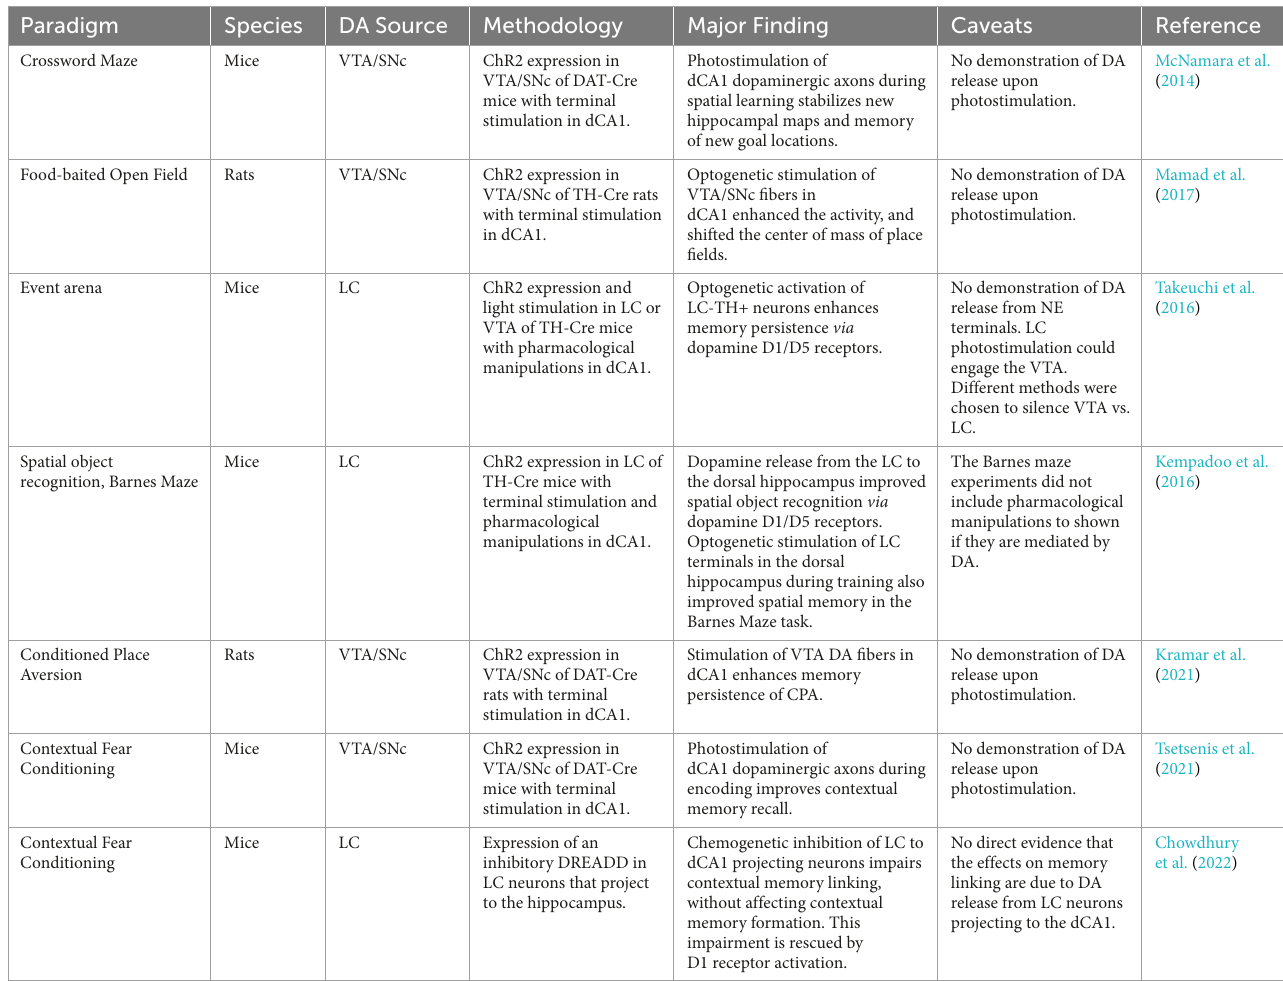
TABLE 1 Summary table of circuit-specific studies showing the effects of different sources of DA on hippocampus-dependent processes. Paradigm Species DA Source Methodology Major Finding